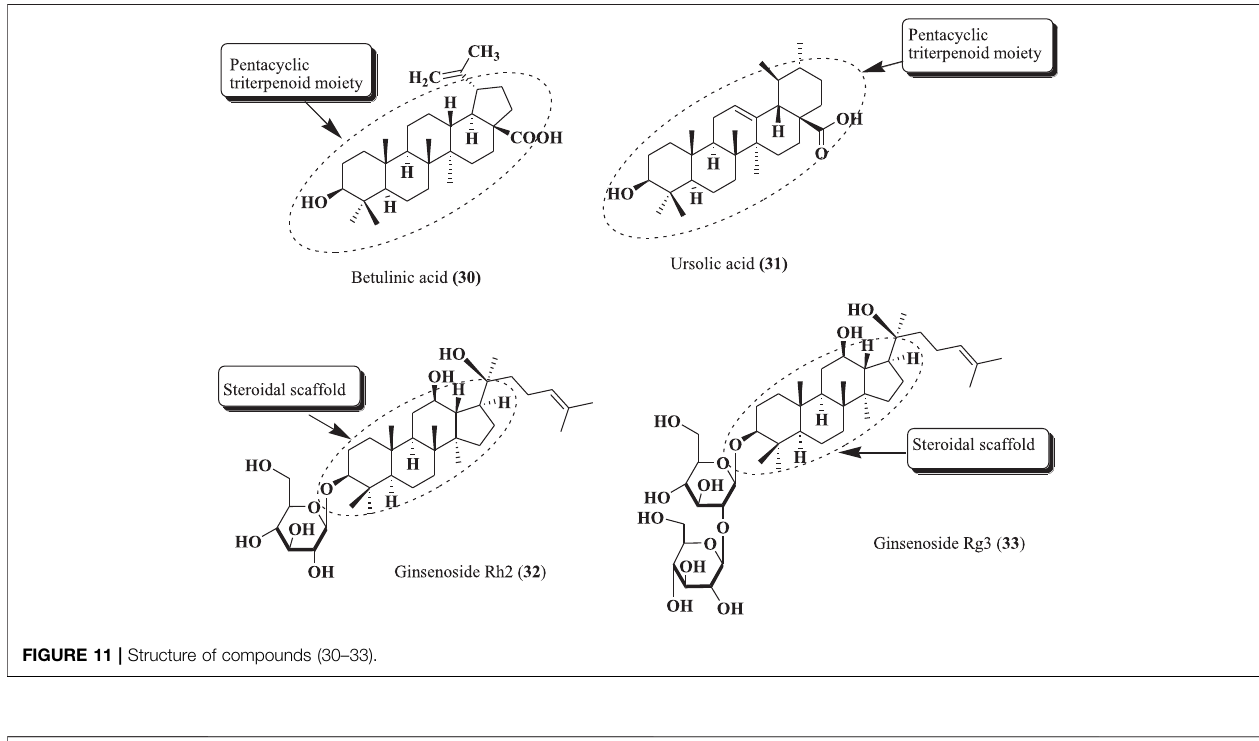
FIGURE 11 | Structure of compounds (30 – 33).